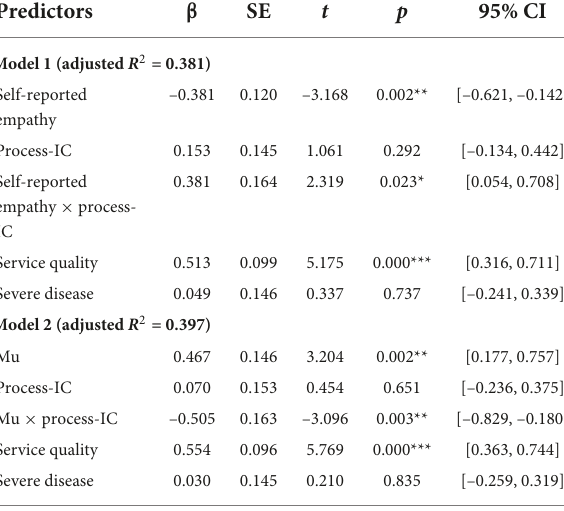
TABLE 2 Standardized coefficients from the two regression